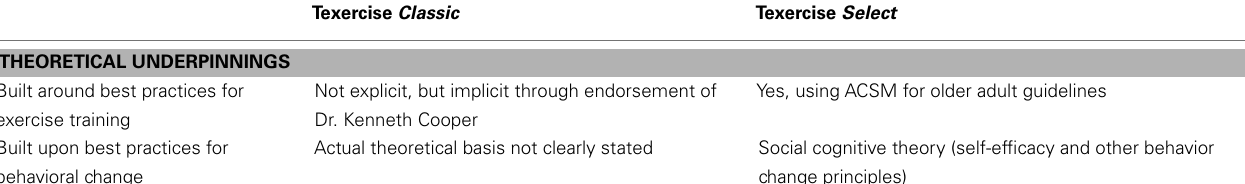
Table 2 | Comparison of features inTexercise Classic and Select